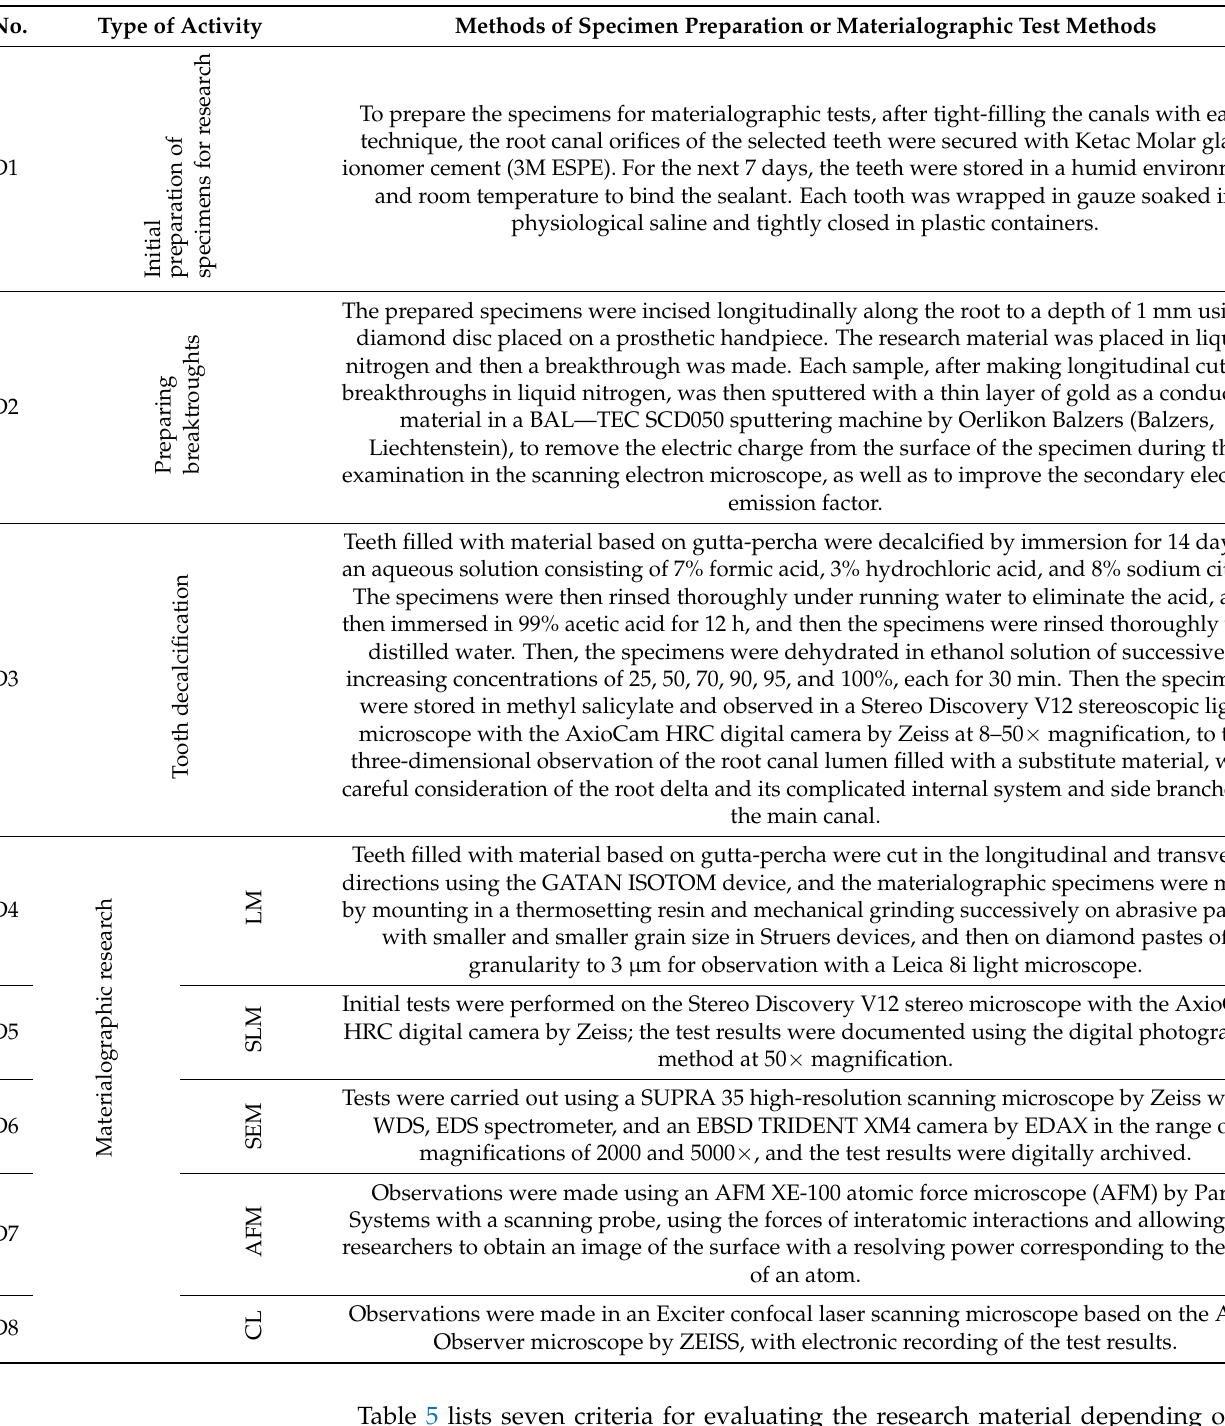
as the methods of the materialographic tests used. Table 4. Methods of preparing specimens and methods of materialographic research to evaluate the effectiveness of root canal